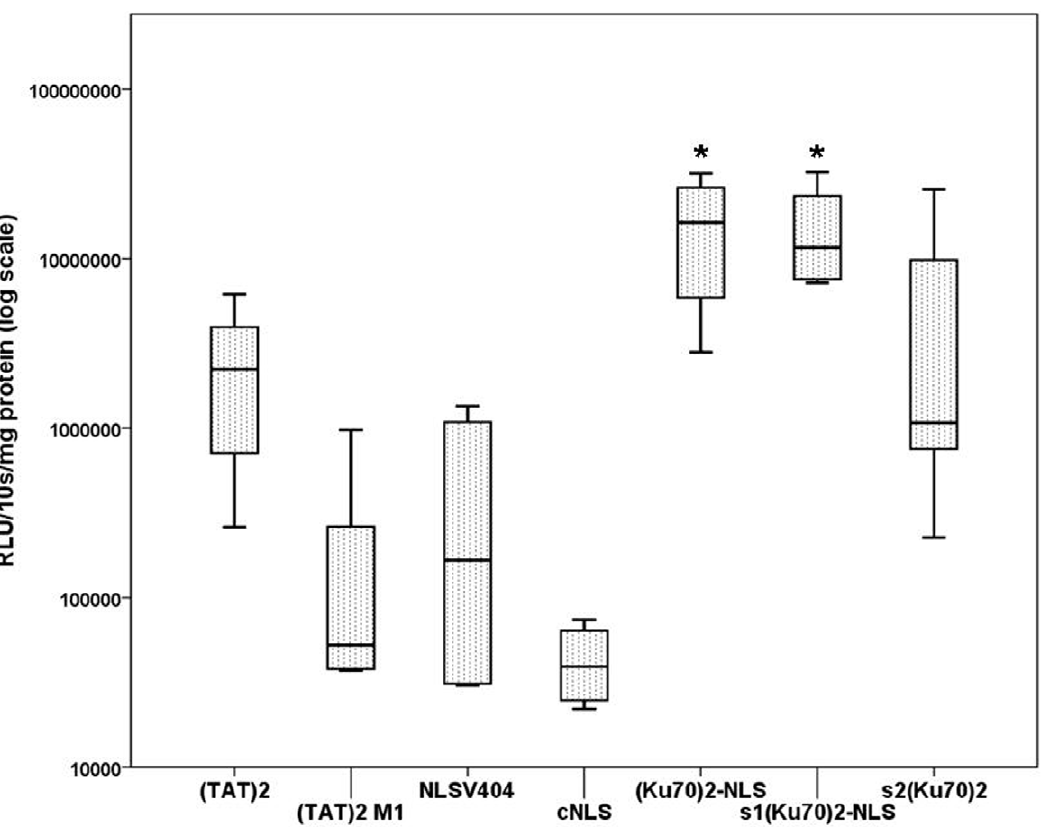
Figure 2. Ku70 2 -NLS in comparison to monopartite nuclear localization sequences. BEAS-2B cells were transfected with Ku70 2 -NLS/DNA complexes or the monopartite active NLS (TAT) 2 or NLSV404, and their nuclear transport deficient sequences (control) NLS (TAT2M1 or cNLS). All the complexes were generated in HBS (charge 6 =5). Transgene expression of Ku70 2 -NLS and s1Ku70 2 -NLS was significantly higher (p , 0.05, Mann- Whitney-U-Test) compared to the respective monopartite NLS (TAT) 2 or NLSV404. Transgene expression of Ku70 2 -NLS and s1Ku70 2 -NLS compared to the control peptide s2Ku70 2 was close to significance. This study clearly suggests an advantage of the bipartite NLS over monopartite NLS.